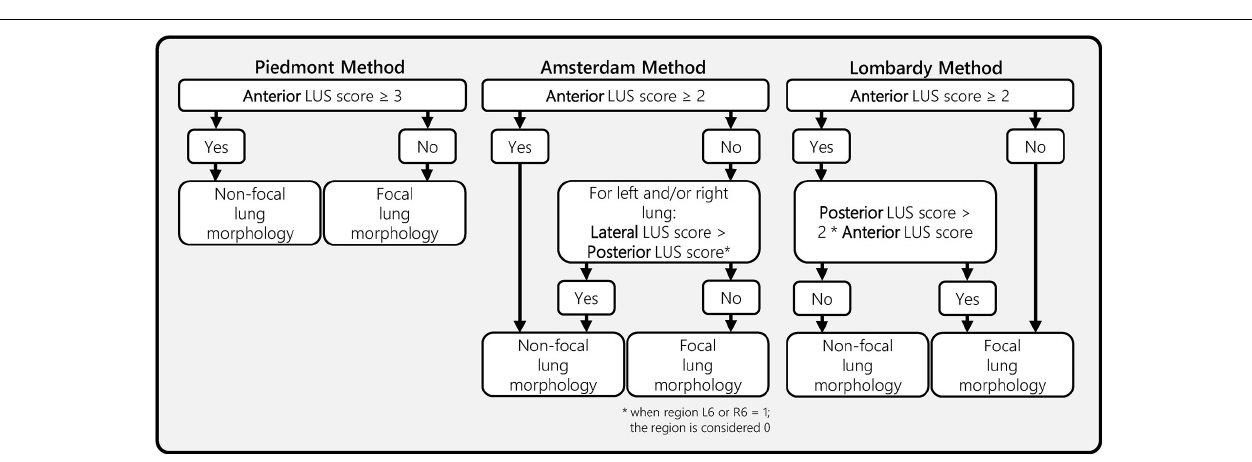
FIGURE 4 | Ultrasound lung morphology assessment methods. This figure presents three LUS morphology assessment methods that were designed and/or evaluated in this study. All three methods classify focal or non-focal lung morphology based on LUS aeration scores from a 12-region LUS exam. The anterior, lateral, and posterior LUS scores were defined as the sum of the LUS aeration score in the four anterior, lateral, and posterior regions, respectively. The Piedmont method was previously proposed in a study from Costamagna et al. (2021). The Amsterdam and Lombardy method were developed for the purpose of this study by two expert panels from the corresponding regions. LUS, lung